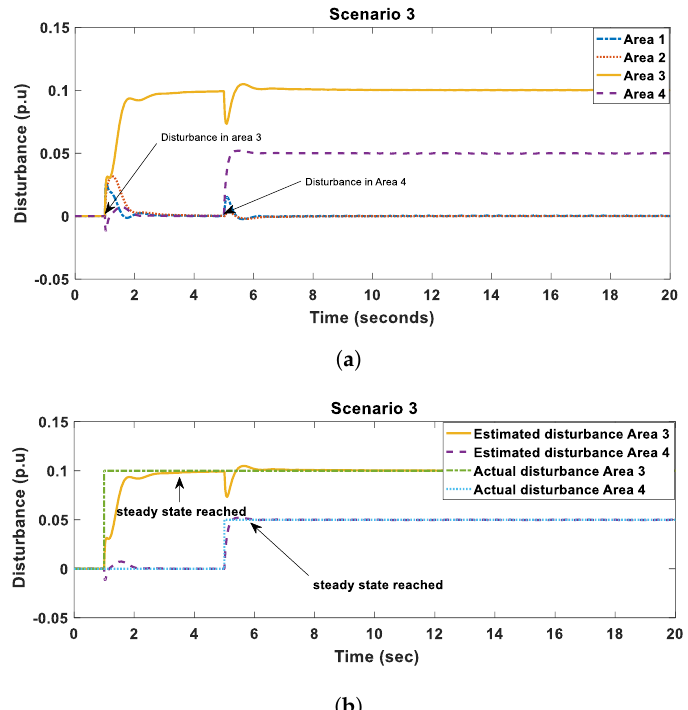
Figure 10. Scenario 3: ( a ) estimated disturbances and ( b ) actual vs. estimated disturbances. Finally, in scenario 4 a large and medium disturbances occurred in area 1 and area 4 respectively, both at t = 1. From Figure 11a,b, it took only 1.5 s in both cases to estimate the disturbance. It is also important to note that due to power line deviations in cases of two disturbance occurring at different times, the observed disturbance for the first occurred disturbance will drop then quickly return to its actual value.